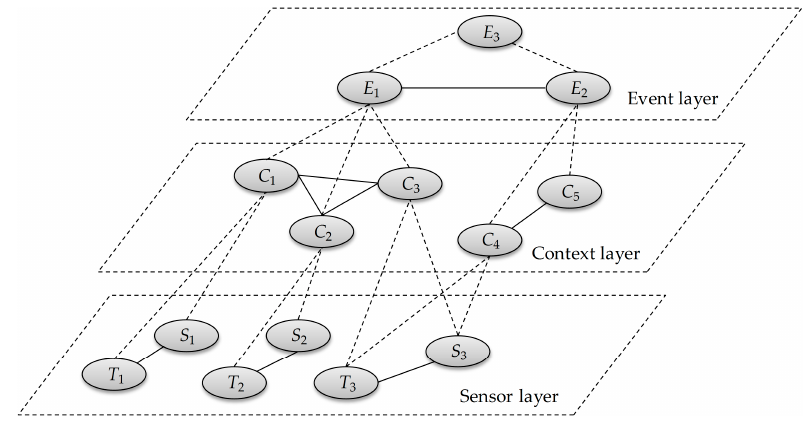
Figure 1. Three-level information fusion model for event recognition.